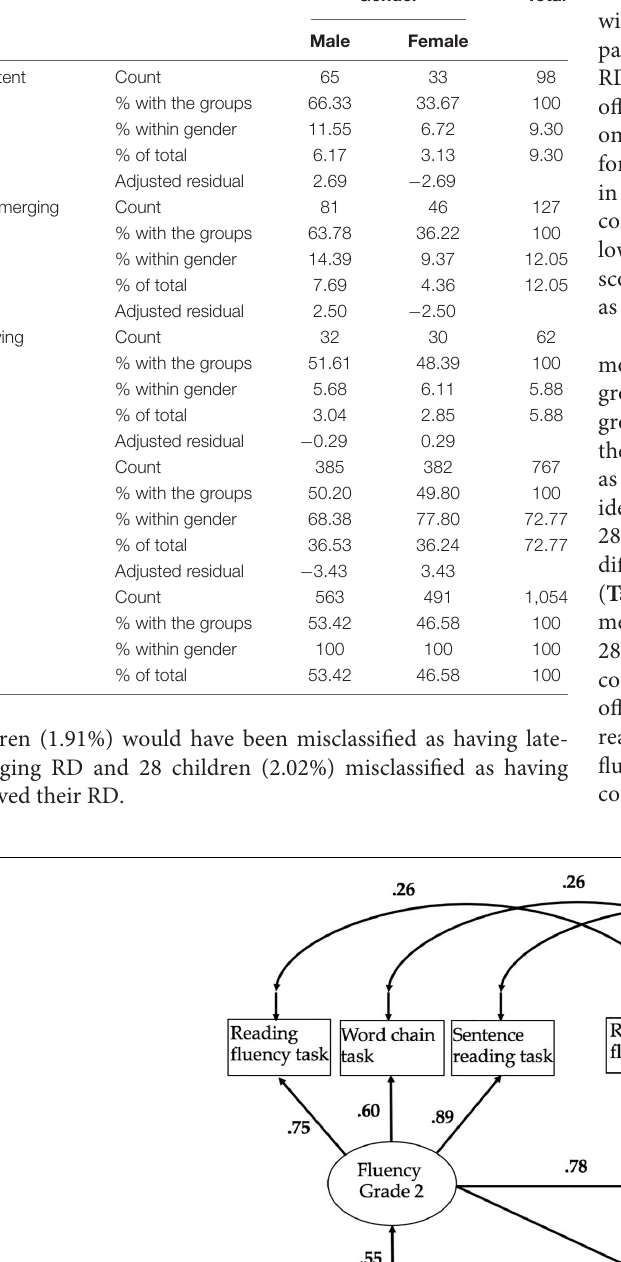
TABLE 5 | Prevalence of boys and girls in each group based on observed data. Group